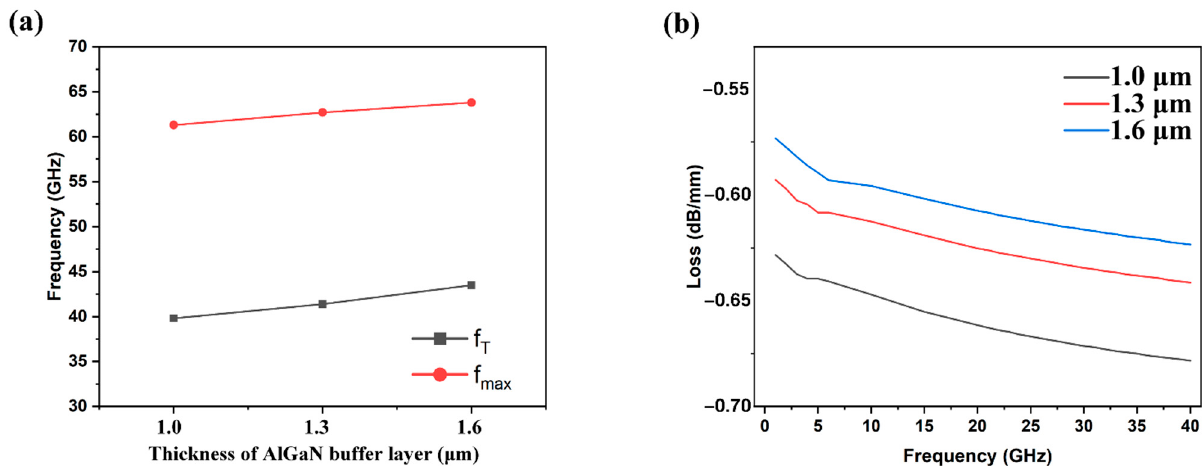
Figure 6. ( a ) f T and f max of the HEMT with different thicknesses of AlGaN buffer layer; ( b ) the RF losses of the CPW with the HEMT with different thicknesses of AlGaN buffer layer.